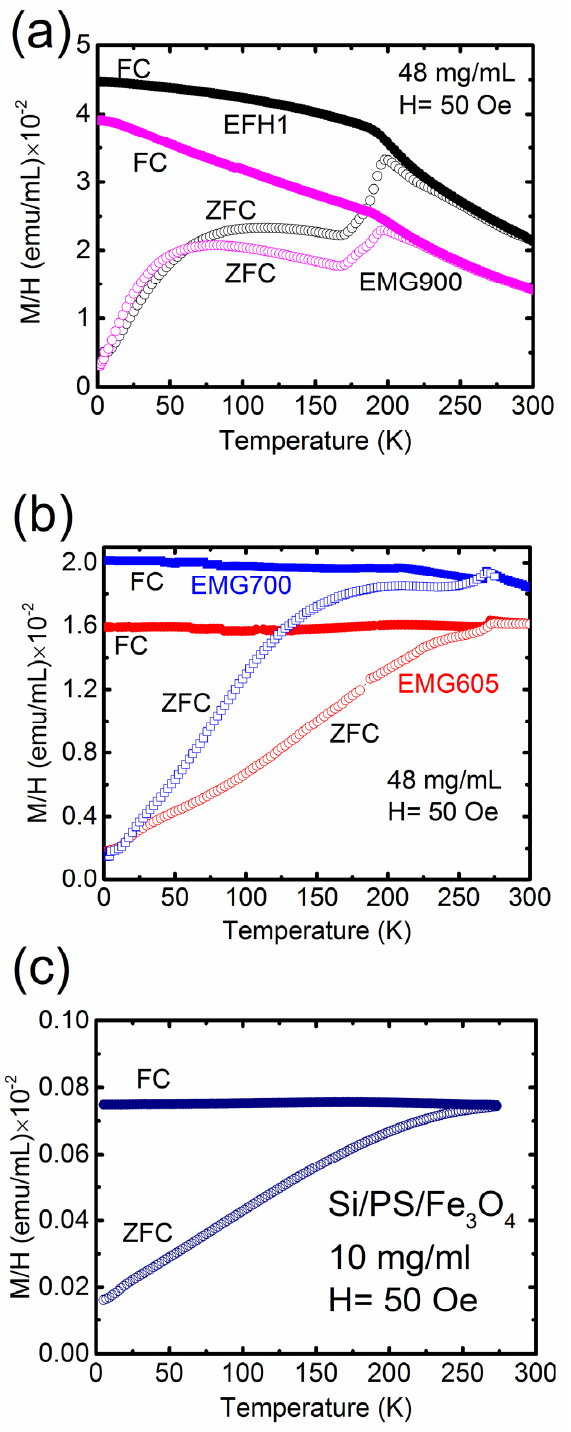
Figure 3. ZFC and FC magnetization behavior of the ( a ) Isopar-M-based EMG 900 and EFH1 samples; ( b ) water-based EMG 700 and EMG 605 samples; ( c ) water-based Si/PS/Fe 3 O 4 sample. by changing the concentration or physical confinement of the MNPs. Vargas et al.